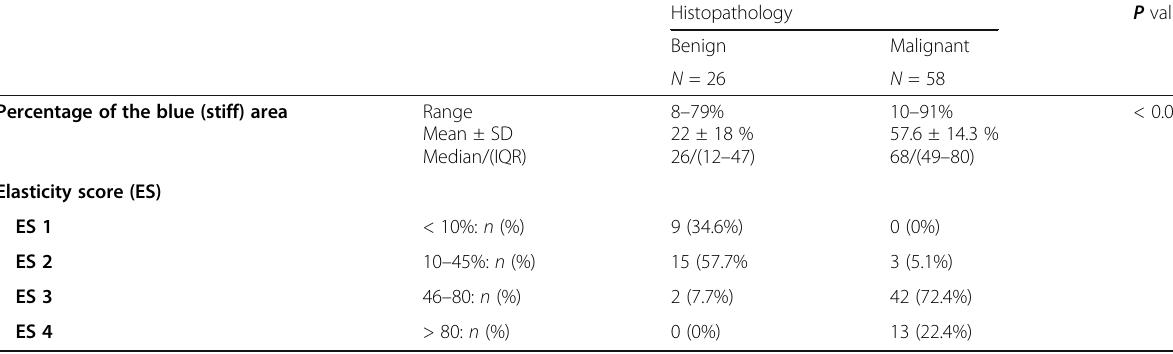
Table 2 Relation between elasticity score and final histopathological diagnosis